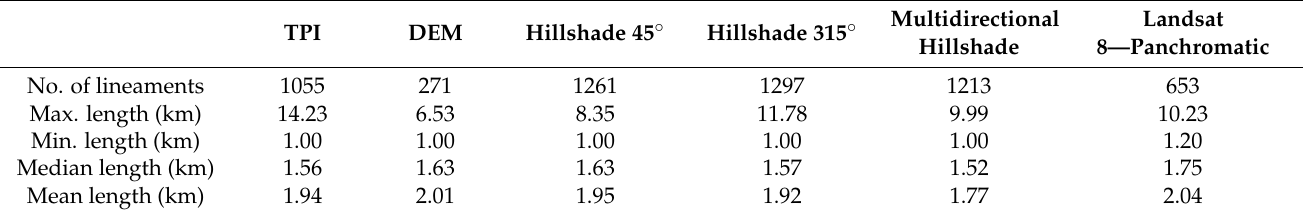
Table 2. Basic statistics of the automatically extracted lineaments from the remotely sensed image. TPI DEM